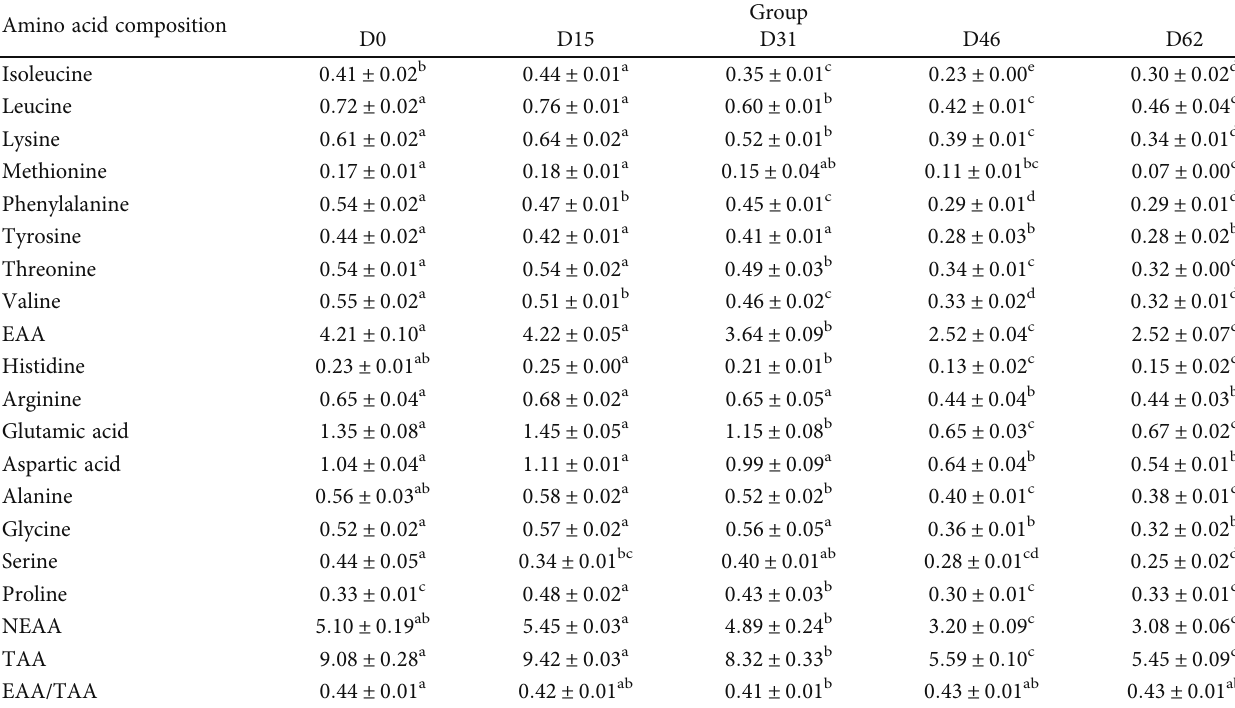
Table 5: Amino acid composition of female E. sinensis hepatopancreas in rice-crab coculture system at di ff erent developmental periods (% wet